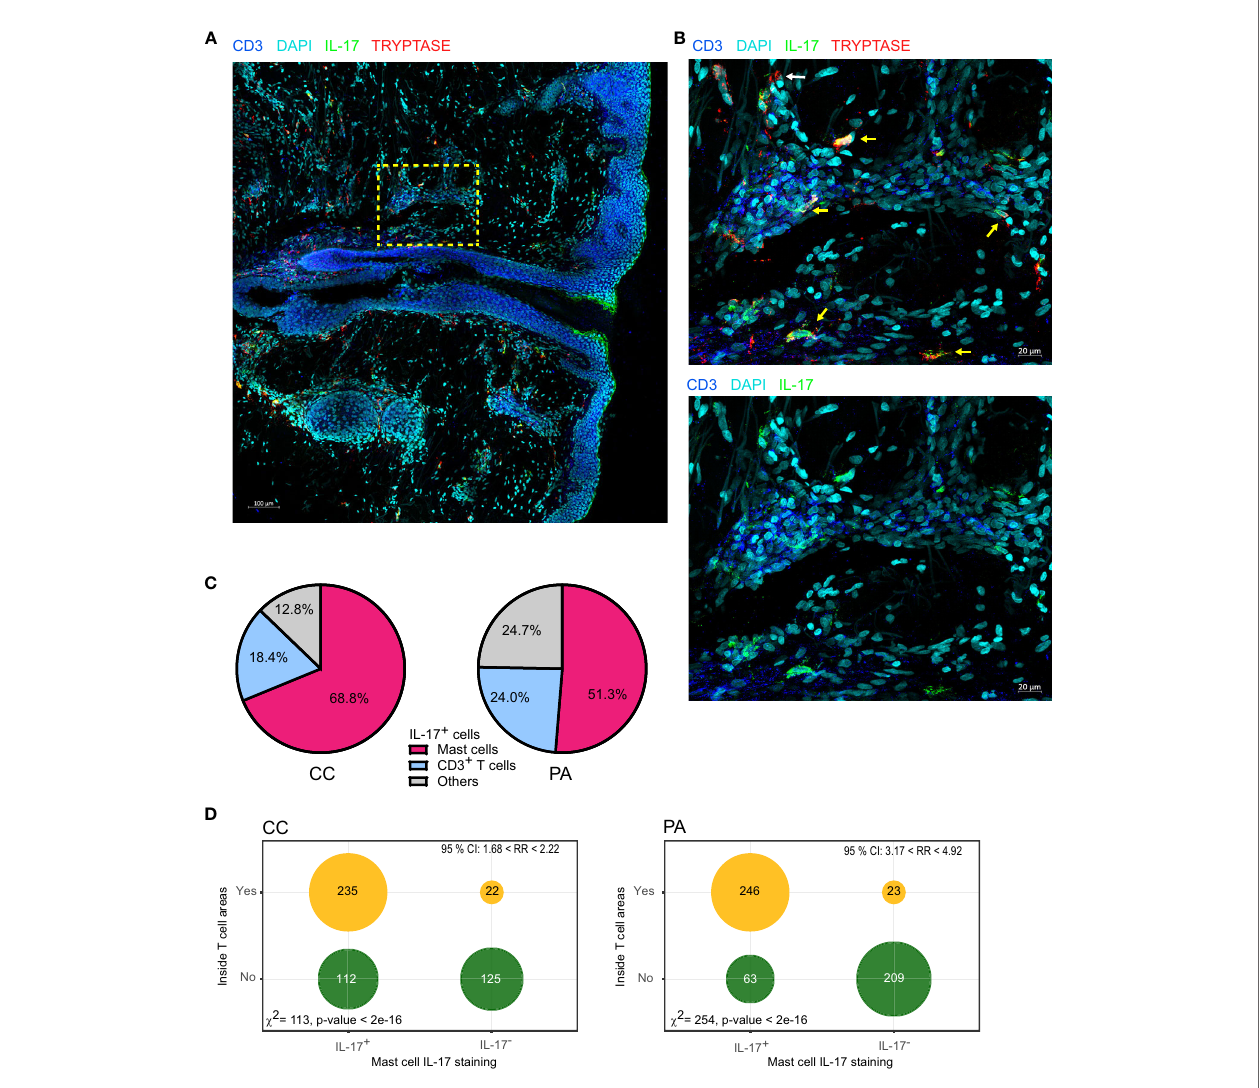
FIGURE 4 | Mast cells are the main cells staining IL-17 + in the early stages of acne. (A) A representative image depicting IL-17, CD3 and tryptase staining (CC stage). (B) High-magni fi cation image showing IL-17 + mast cells (yellow arrows) near perifollicular area (bottom) and perivascular area (top); white arrow points IL-17 - mast cell. (C) Image quanti fi cation of IL-17 + cells among CD3 + (T cells), Tryptase + (mast cells), pooled data from 4 patients either at CC or PA stage as indicated. (D) Tryptase + cells were classi fi ed according to IL-17 staining and to location (inside or outside T cell rich areas as depicted in Supplementary Figure 2 ), resulting contingency tables of counts are plotted (pooled data from 4 patients); c 2 test for independence and relative risk are